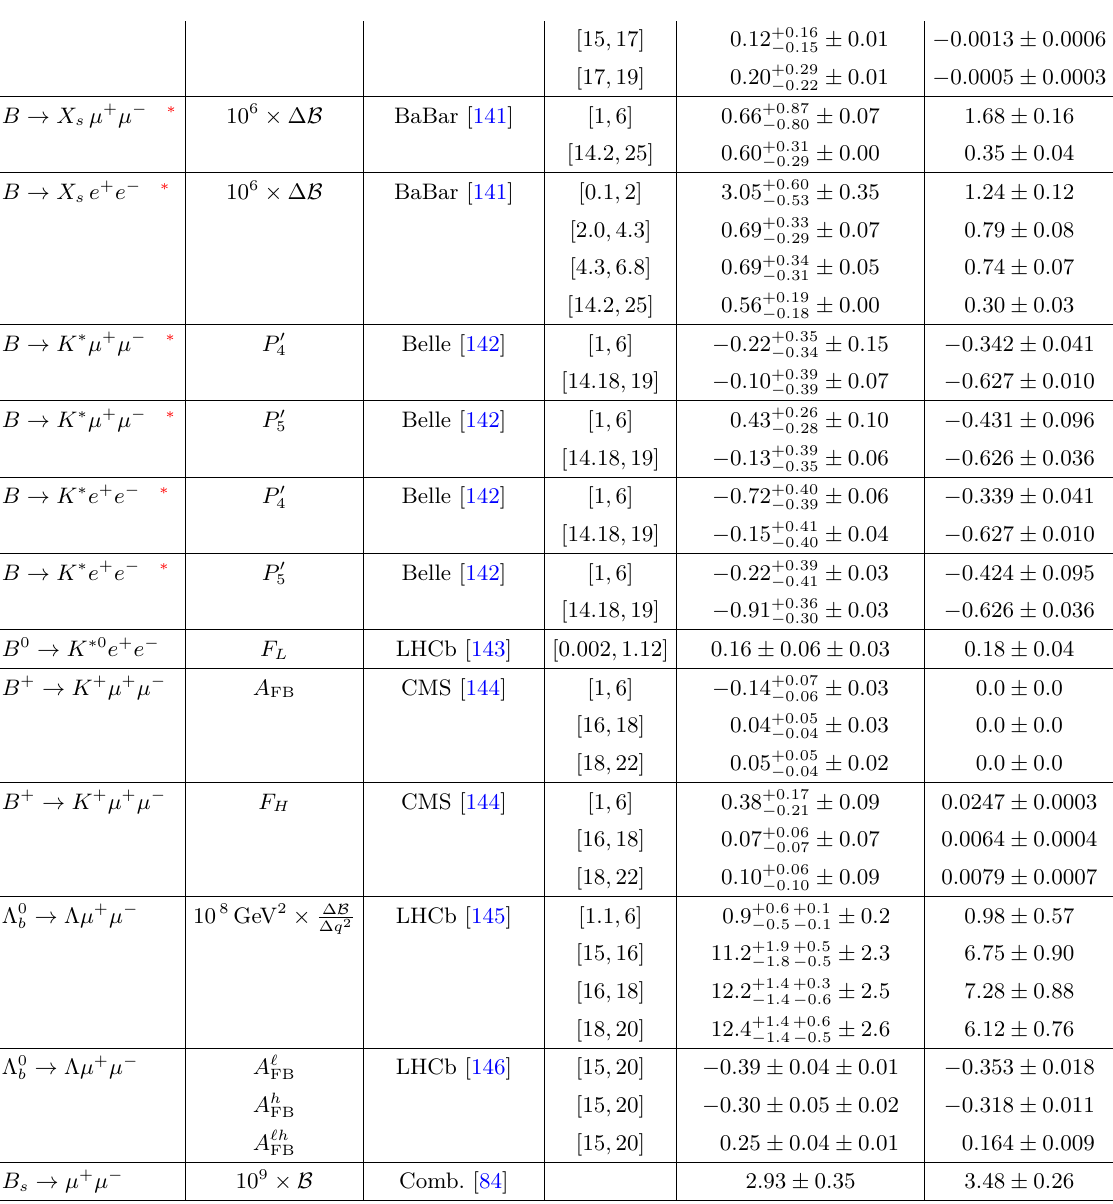
Table 7. Table of b → s‘ + ‘ − observables (except R ) used in the analysis. We include K ( ∗ ) correlations between measurements when provided by the sources. The stated SM predictions are our calculations through flavio . The modes marked by * assume averaging of B + and B 0